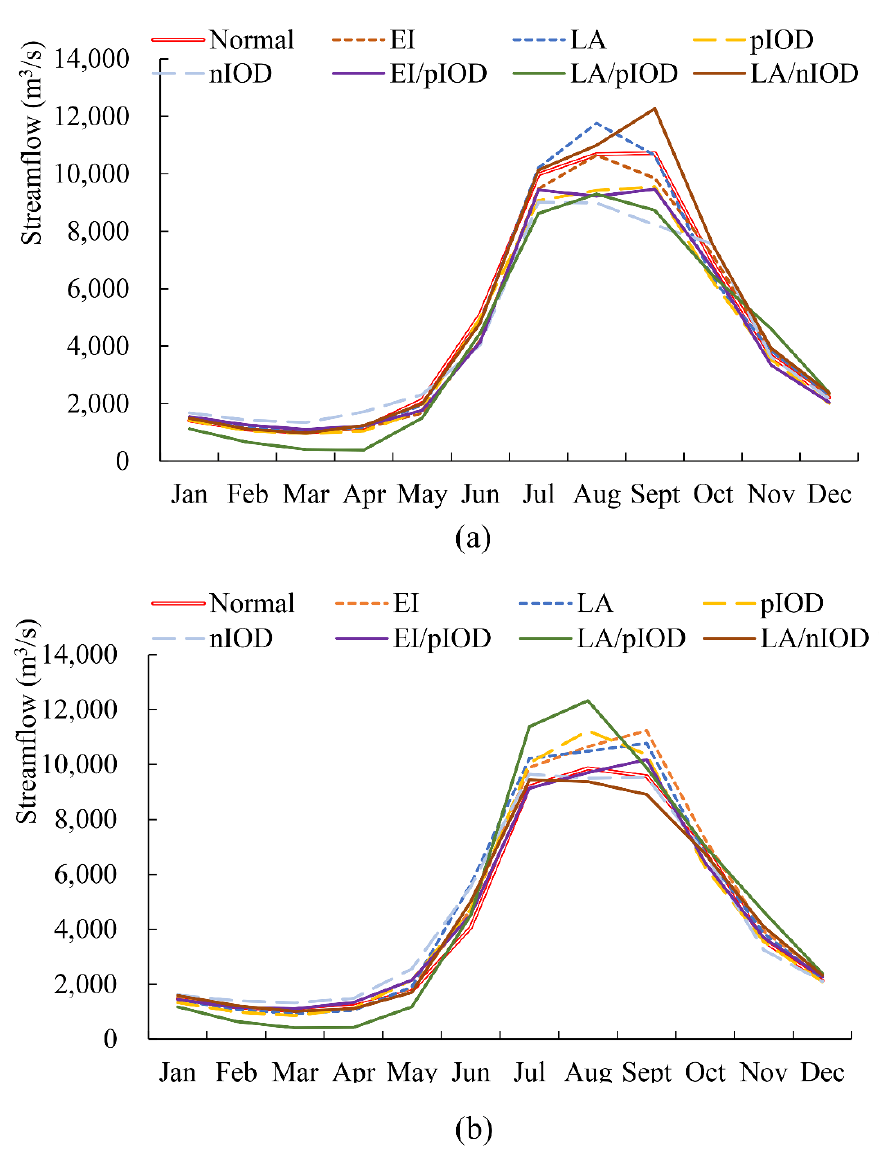
Figure 6. Streamflow distribution in neutral years and those corresponding to ENSO/IOD event years in ( a ) developing years and ( b ) decaying years.